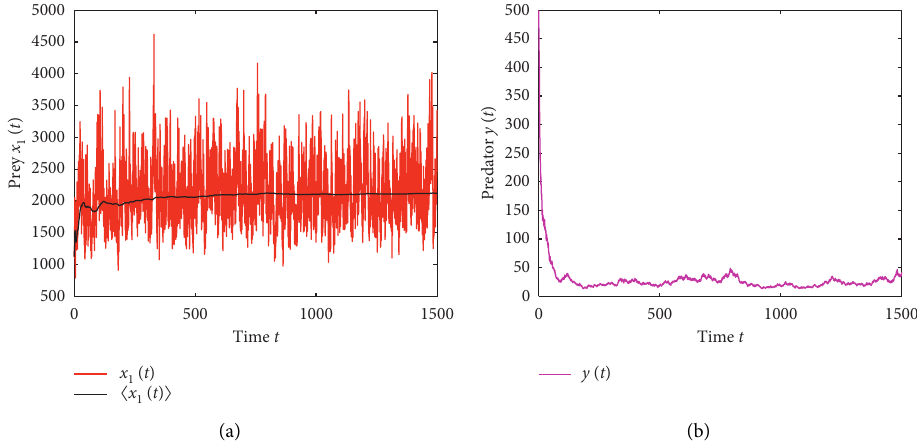
Figure 12: The trajectories of (5) with σ 2 ( t ) . (b) prey x 2